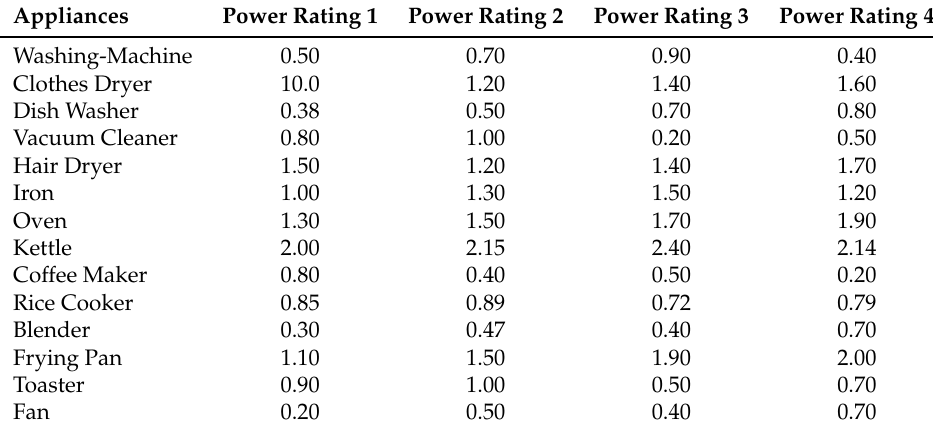
Table 11. Random power ratings in (kWh).